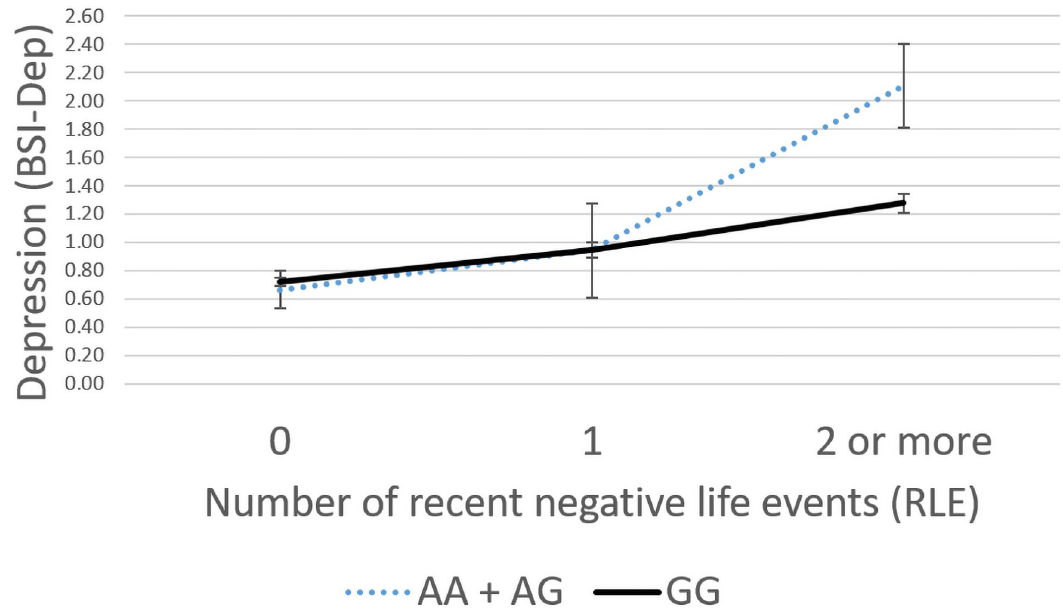
Fig 3. Linear regression analyses indicated a significant interaction between P2RX7 rs61953400 and exposure to recent life events on current depression, with the minor A allele as a risk allele. Linear regression indicated a significant interaction between P2RX7 rs61953400 genotype and recent stressful life events (RLE) on current depression scores (BSI-DEP) according to the additive (p < 0.0015, FDR Q = 0.0062) and dominant (p < 0.0001, FDR Q = 0.0043) models. Presence of the minor A allele was associated with higher depression scores in subjects exposed to severe recent life events conveying a risk effect. On the vertical axis weighted depression (BSI-Dep) scores are shown. The horizontal axis shows recent life events (RLE) occurring within the past year as measured by the List of Threatening Experiences [36] categorised as 0 –low exposure (0 events reported) 1 –medium exposure (1 event reported) or 3 –high exposure (2 or more events reported). While regression models were used in the analyses, the figure depicts results from ANOVA solely for visualisation purposes. Mean and SEM values are displayed.